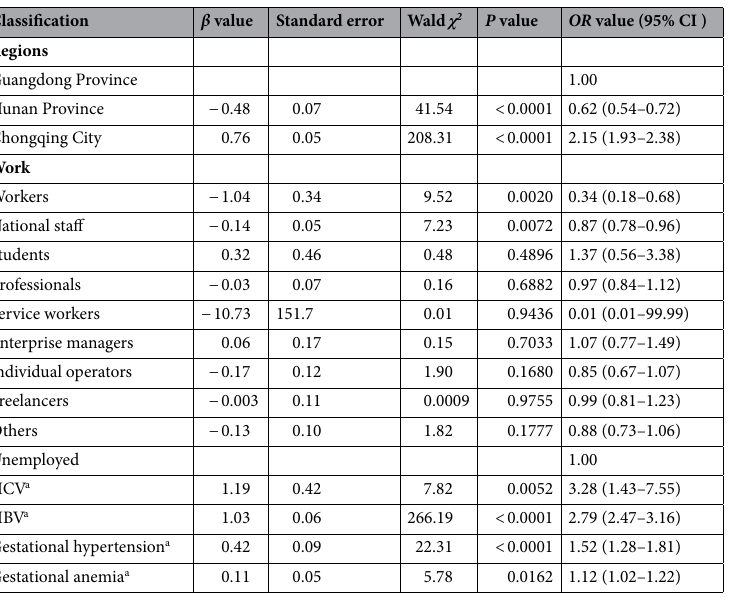
Table 4. Multivariate logistic regression model analysis of associated factors of ICP among pregnant women in three provinces. a "No" was used as the reference